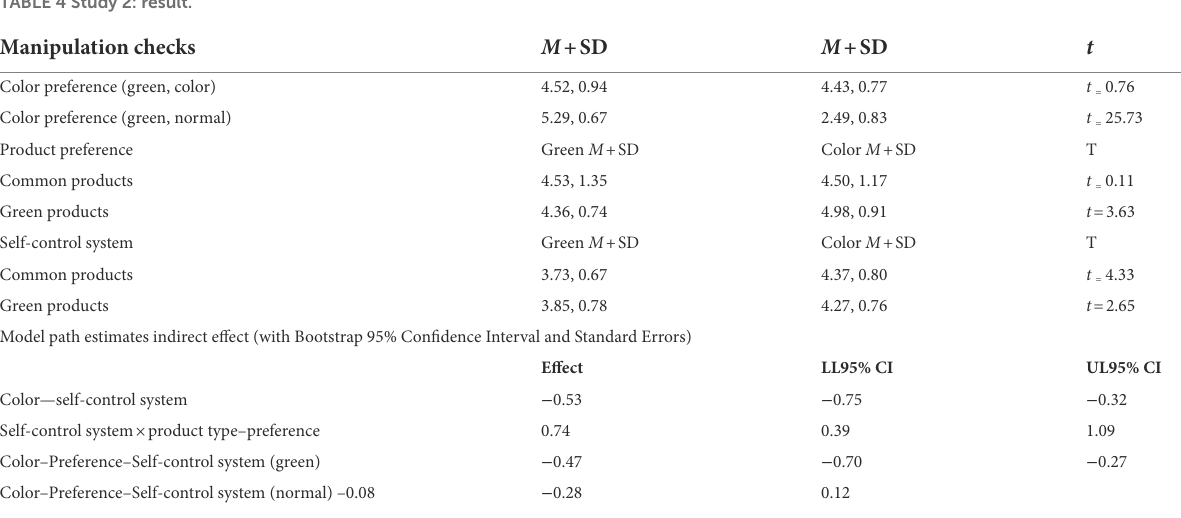
TABLE 4 Study 2: